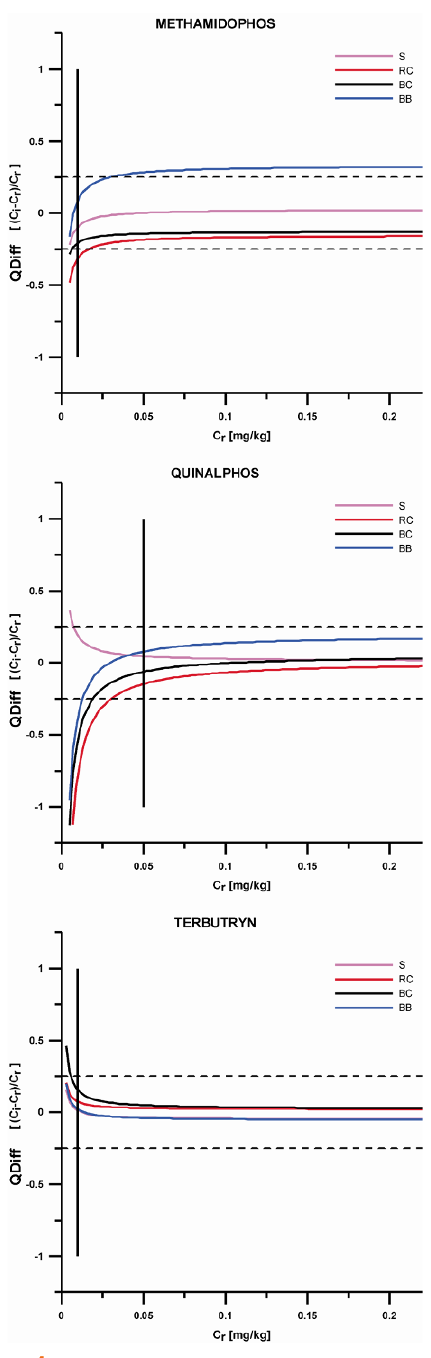
Figure 1. Relative quantification differences (QDiff) of methamidophos, quinalphos and terbutryn determination for four soft fruits: black and red currents, strawberries and blackberries; raspberries were used as a representative matrix for the calibration, C is a (i) concentration calculated using the fruit specific matrix is a concentration calculated calibration curve, C (r) using the representative matrix calibration curve. A vertical solid line is placed at C equal to a pesticide (r) maximum residue level (MRL); a horizontal dashed line represents ± 25% acceptance